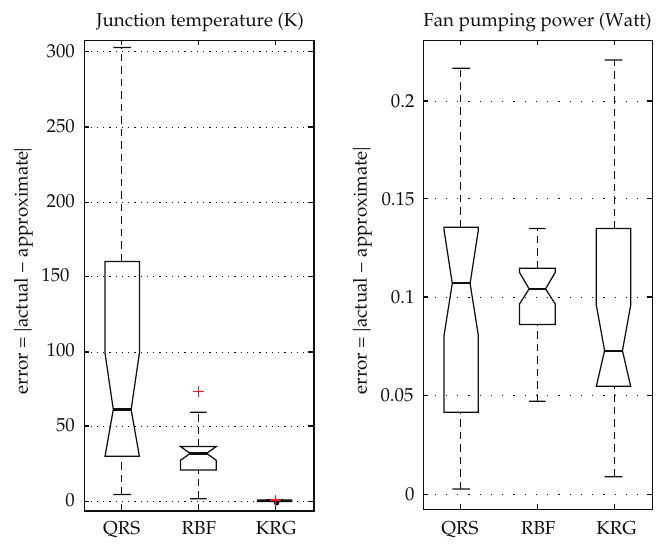
Figure 9: Accuracy assessment of the surrogate